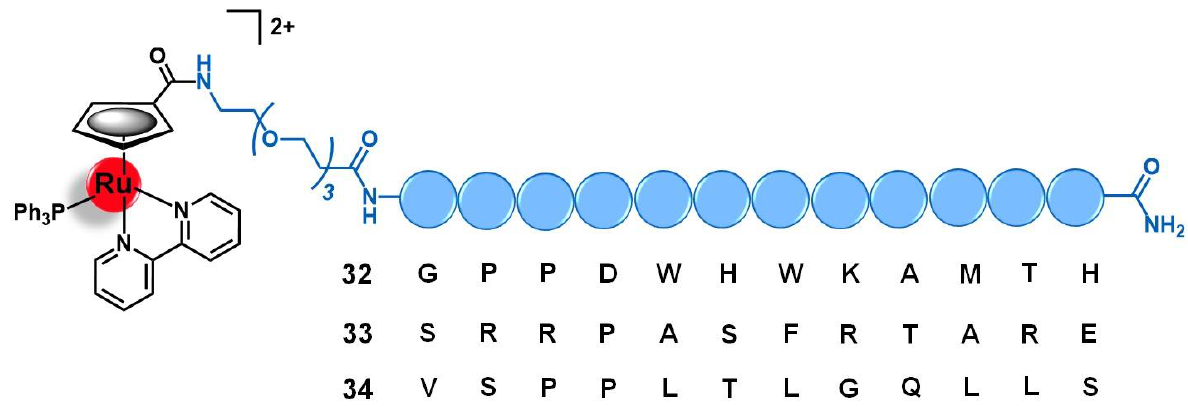
Figure 11. Ru(II)-conjugates for targeting the fibroblast growth factor receptor (FGFR) containing the peptides GPPDWHWKAMTH (32), SRRPASFRTARE (33), or VSPPLTLGQLLS (34) as vectors.